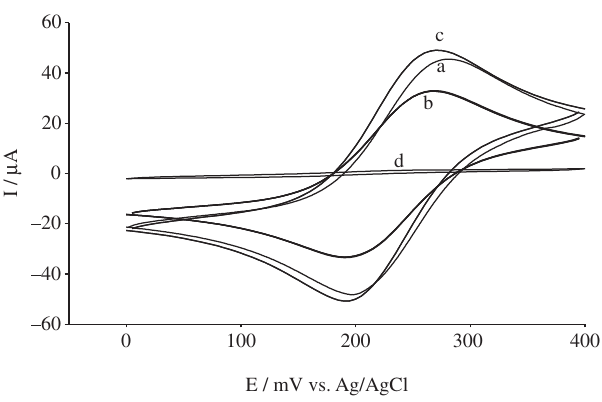
3- using gold Figure 6. Electrochemical response of GC/TFSF: a) before and b) after 6 1 minute accumulation of Hg 2+ ions in an open-circuit. Scan rate of 10 mV/s and pulse amplitude of 100 mV.